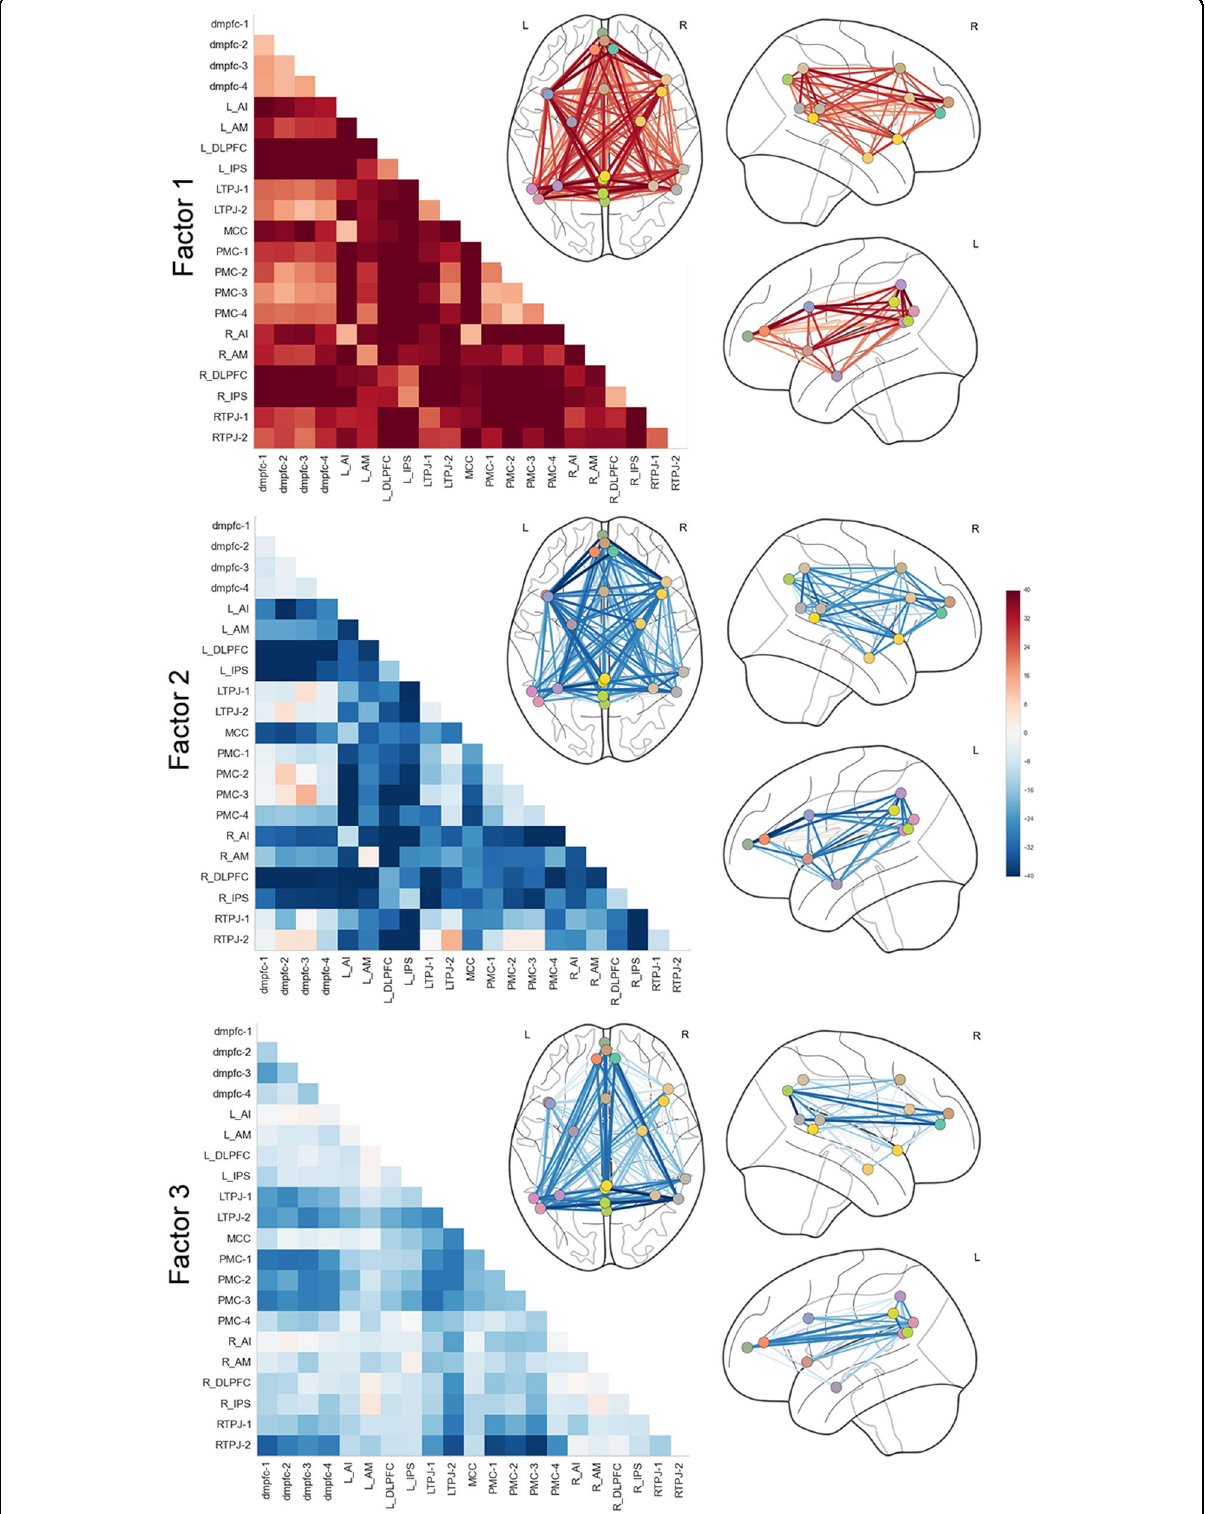
Fig. 4 Three neurobiological factors of variation with distinct connectivity patterns. Bayesian inference allowed extracting a hierarchy of brain- de fi ned subgroups, without access to the clinical diagnoses. Each of the three biological factors re fl ected a coherent pattern of resting-state connectivity between the default mode network (dmPFC-1/2/3/4, PMC-1/2/3/4, and bilateral TPJ-1/2), dorsal attention network (bilateral dlPFC and IPS), and salience network (bilateral AI, MCC, and AM). In each TD, ADHD, or ASD individual, the resting-state measurements of overall network- coupling patterns were driven by fl exible recombinations of these three factors of connectivity variation. L/R left/right